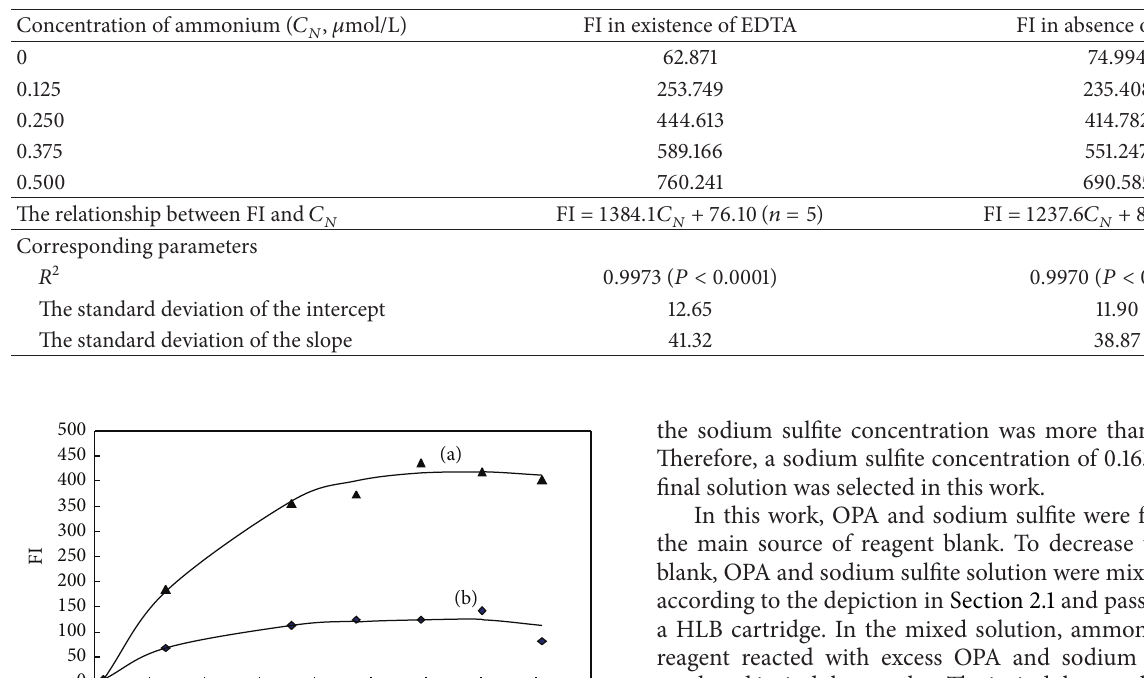
Table 2: The FI of different concentration standard ammonium solution in existence and absence of EDTA.